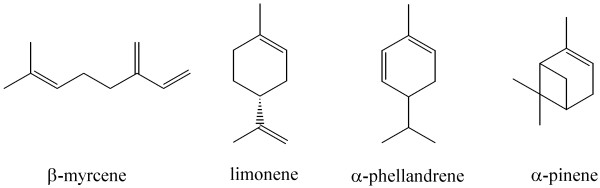
Monoterpene substrate range ofC. defragrans [40].